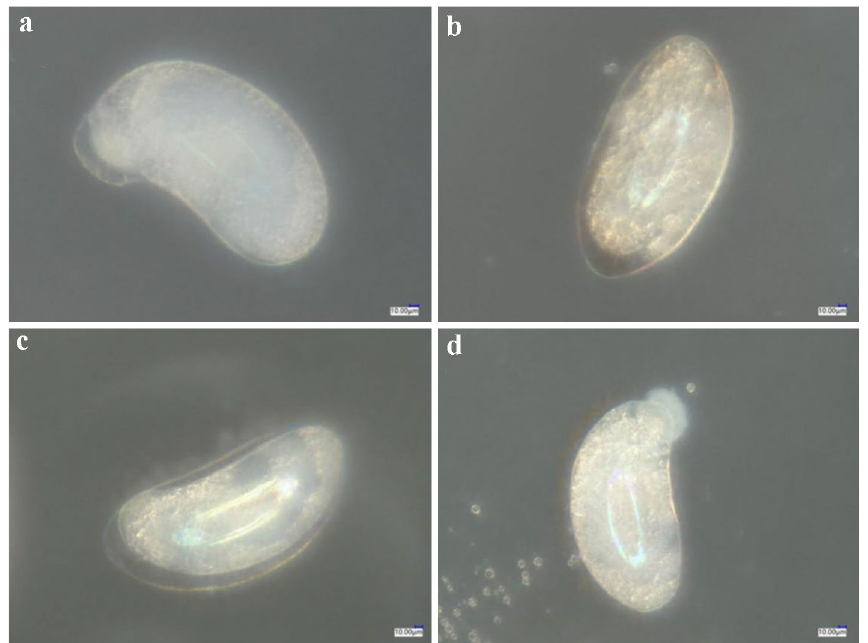
Figure 1. The effect of spirotetramat on external morphology of isolated 0-h-old eggs of F. occidentalis . ( a ) 0-h-old isolated eggs of normal developing thrips; ( b ) yellowish-brown, developmentally deformed eggs after spirotetramat treatment; ( c ) eggs with shrunken oocytes after spirotetramat treatment; ( d ) eggs with apical rupture of the eggshell after spirotetramat